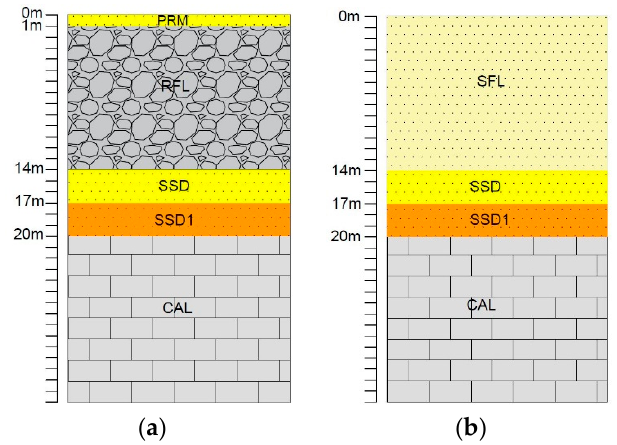
Figure 7. Ground models at the site location after reclamation. ( a ) represents the revetment area in which rockfill has been placed and ( b ) represents the central zone of the area reclaimed with sand fill.